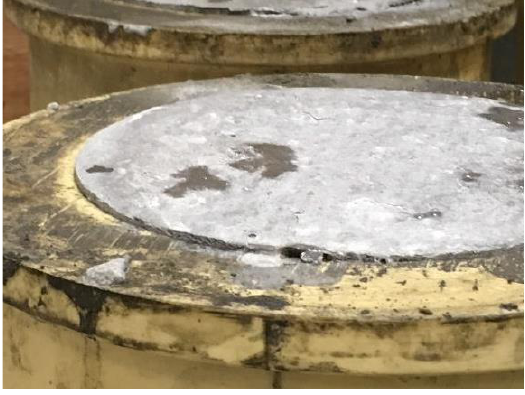
Figure 5. Expansion of specimens inside the moulds.